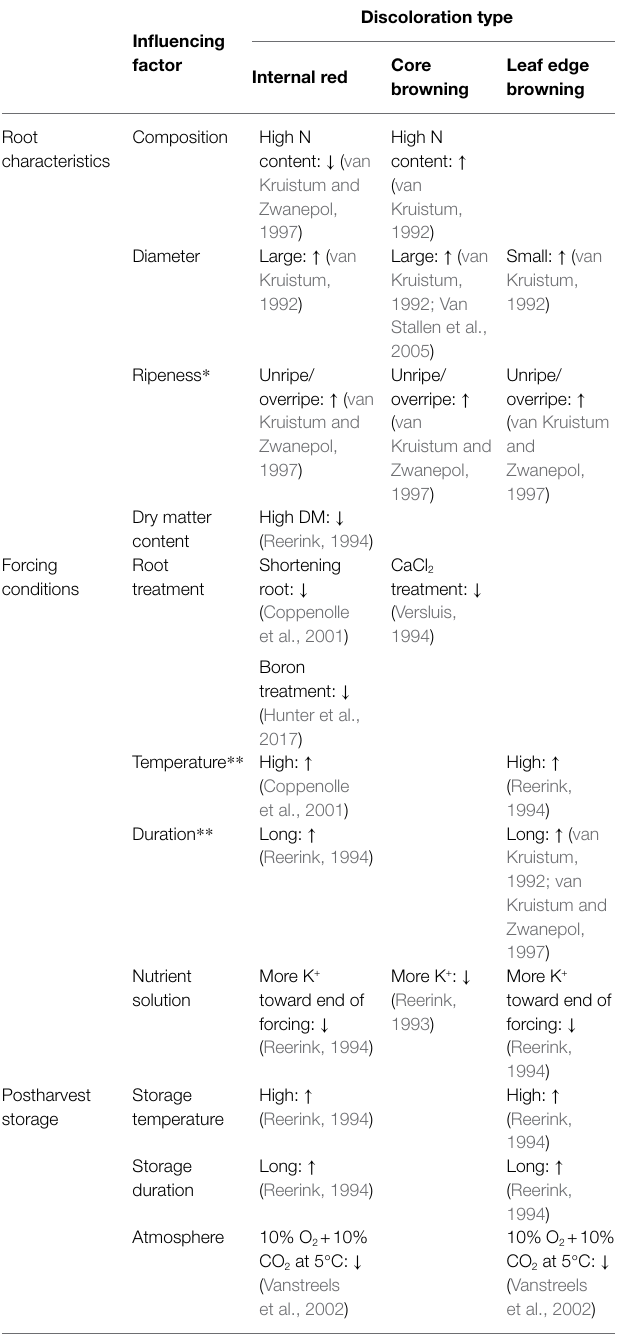
TABLE 1 | Overview of influencing factors during root cultivation, forcing and postharvest storage of witloof chicory on the sensitivity toward the development of internal red, core browning, and leaf edge